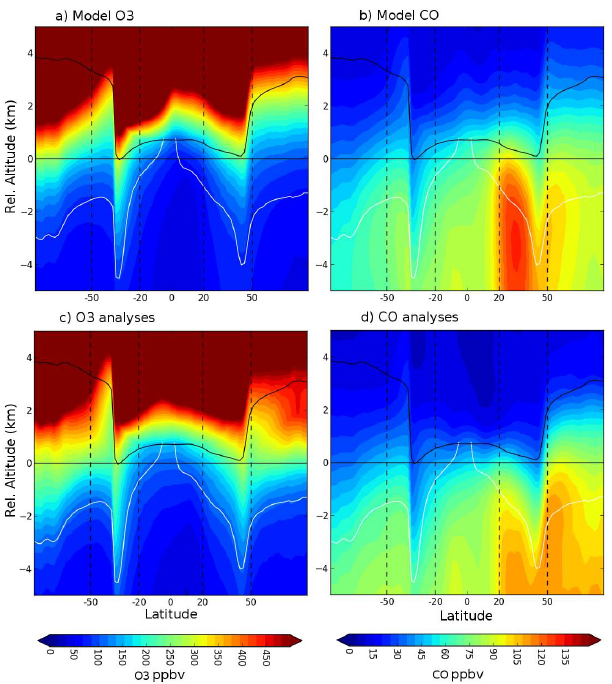
Fig. 6. Zonal averages for the month of August 2007 in relative alti- tudes (km) of model O 3 (a) , model CO (b) , O 3 analyses (c) and CO analyses (d) . Dashed black vertical lines mark the regions of interest (i.e., 90–50 ◦ S, 50–20 ◦ S, 20–50 ◦ N and 50–90 ◦ N). The lowermost stratosphere bounds are represented by the 2PVU contour in abso- lute value (lower white line), and the 380K isentrope (upper black line).